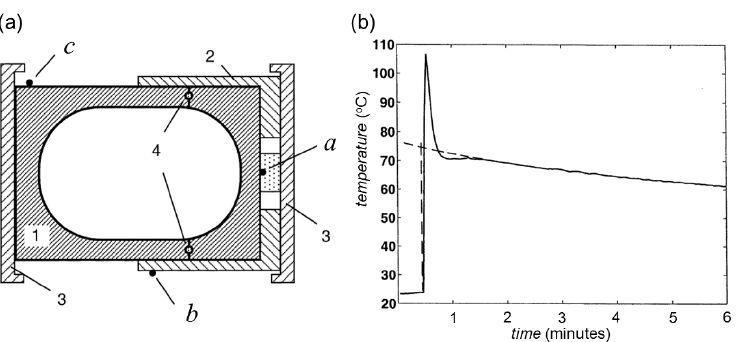
Figure 14. Real-time thermal monitoring of the course of the MSR of the reduction of Fe 3 O 4 by milling with Al metal: ( a ) the milling vessel equipped with thermocouples situated at positions a , b , and c ; ( b ) time-dependent temperature profile measured at position a . Components of the milling vessel: 1—steel body; 2—aluminium screw-on cap; 3—holding clamps; 4—O-ring seal [68] .